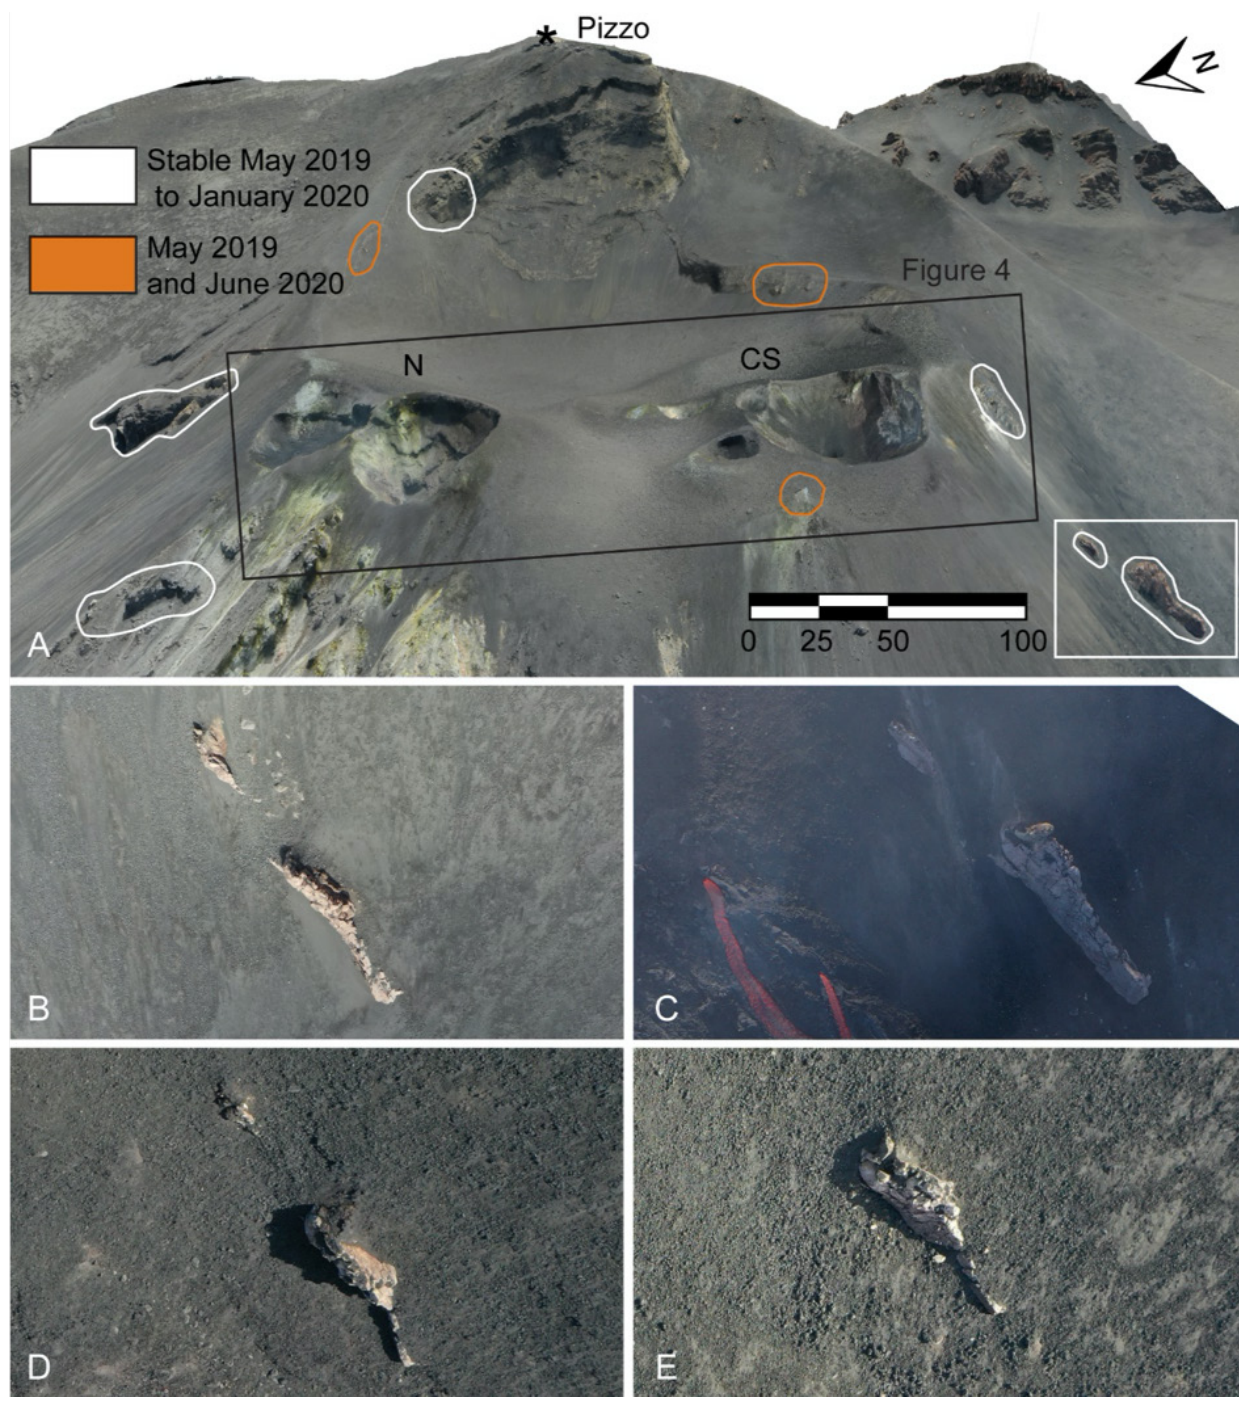
Figure 3: Location of features that were used for the referencing of the five models. [A] shows a 3D model of Stromboli’s crater terrace in June 2019 indications for features that remained stable. The images in [B] May 2019, [C] August 2019, [D] September 2019 and [E] January 2020 show the dyke marked by the white rectangle. N marks the N vent area and CS the CS vent area. The black rectangle indicates the section shown in Figure